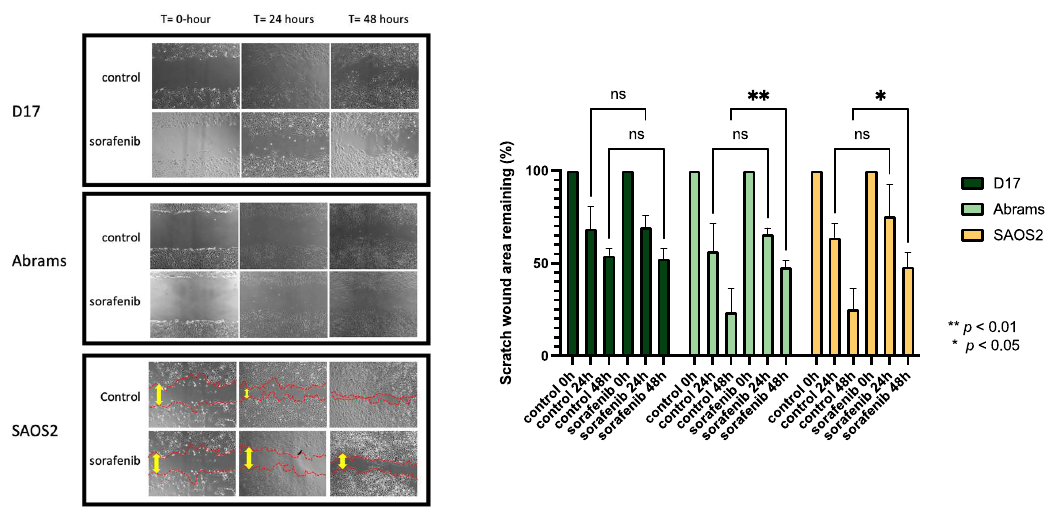
Figure 2. Photomicrographs taken with Nikon camera at 40× magnification, comparing wound healing in three OSA cell lines with and without sorafenib for up to 48 h. (D17: 3 µ M, Abrams: 4 µ M, SAOS2: 3 µ M). **: p < 0.01, *: p < 0.05, and ns (not significant) for sorafenib treatment compared